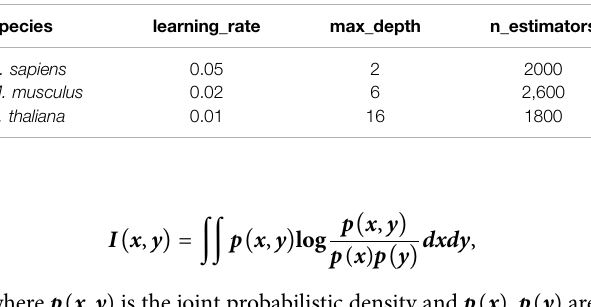
TABLE 3 | The optimal hyperparameters of XGBoost for three